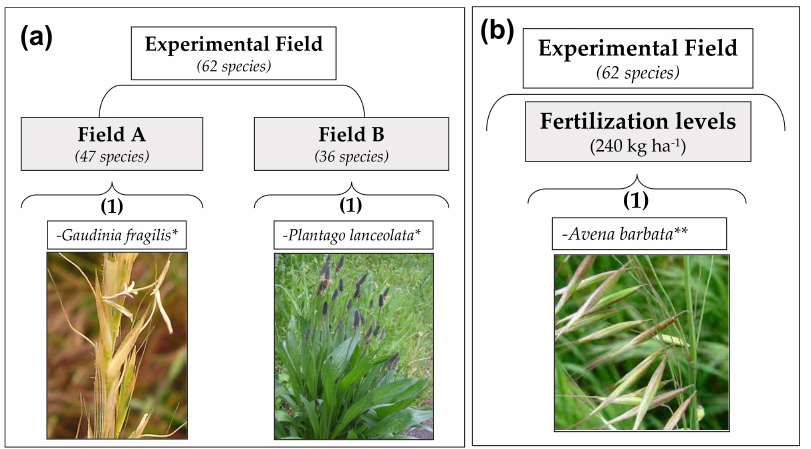
Figure 13. Bio-indicator species of “grazing system” ( a ) and “fertilizer level” ( b ). *: Probability < 0.05; **: Probability < 0.01.